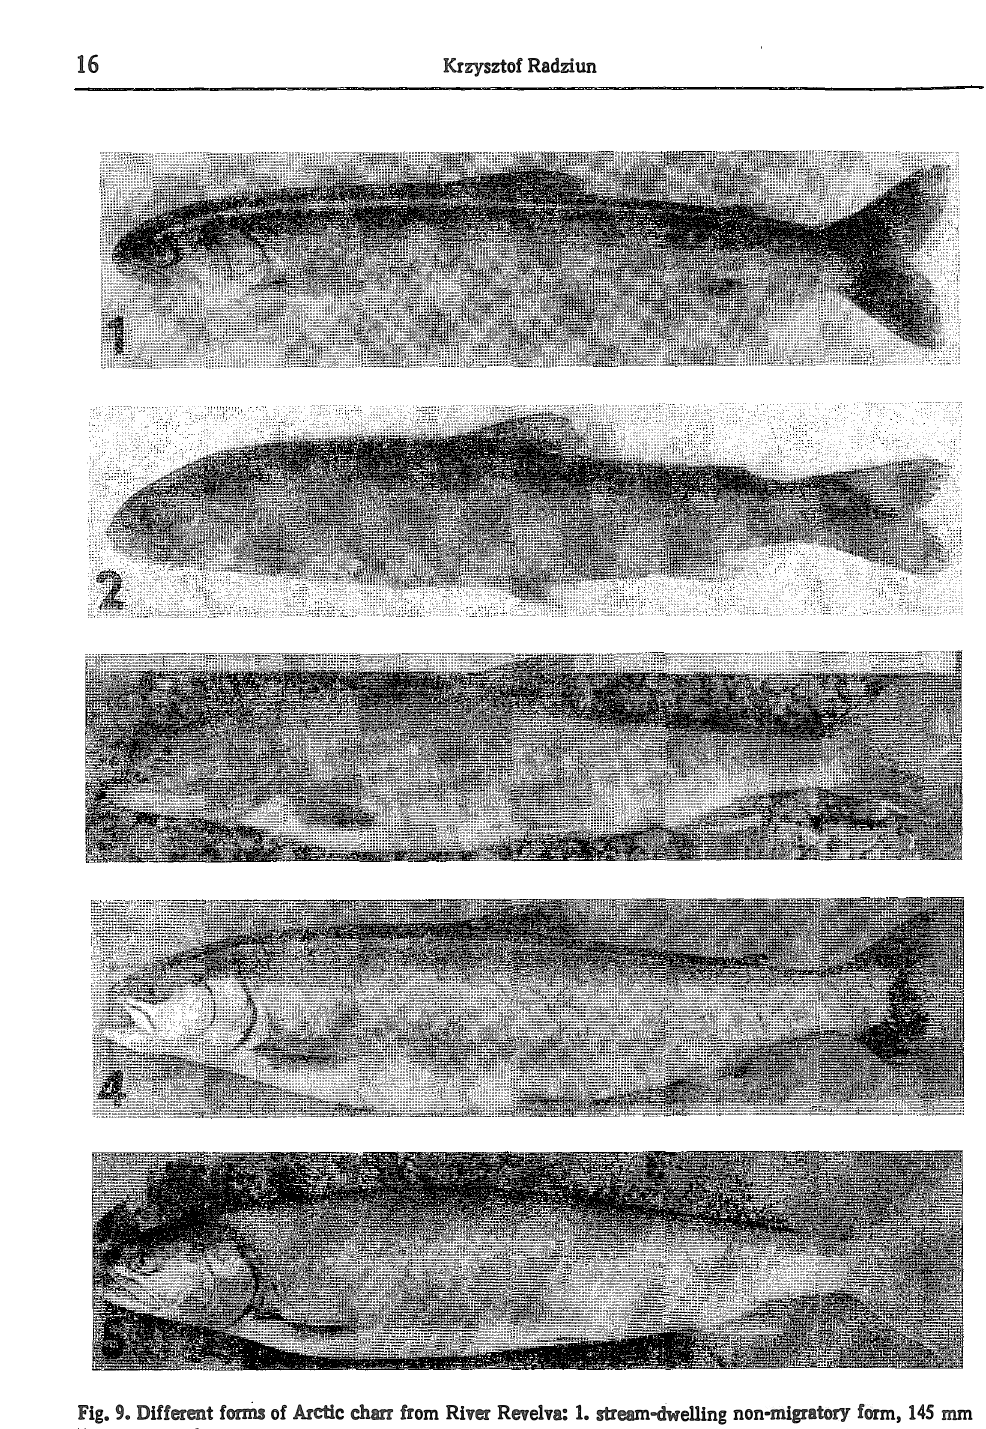
Fig. 9. Different f� of Alcti.e chm from River Revelva: l, sll'oom-dwelling non-migratory form, 145 mm totlll length; 2. juvenile form, 166 mm total length; 3. anadromous, estuazy·dwelling form (male), 431 mm total length; 4. an11dromous femme, 465 mm total length; 5. snadromow female, 620 mm total